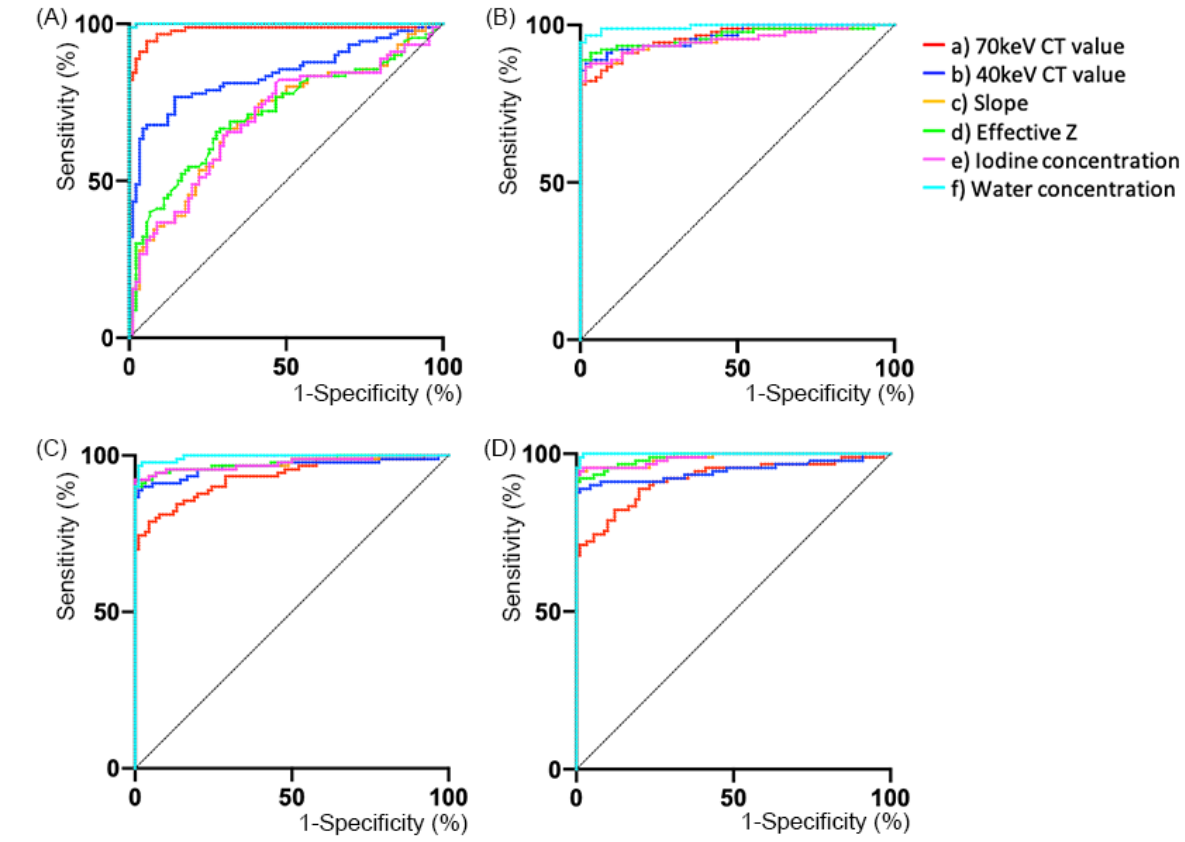
Figure 4. Receiver operating characteristic (ROC) analyses in non-contrast-enhanced ( A ) and contrast-enhanced CT including ( B ) hepatic arterial phase (HAP), ( C ) portal venous phase (PVP), and ( D ) delayed phase (DP) showing the comparisons between the difference in dual-energy CT (DECT) numbers derived from two regions of interest (ROIs) within the same organs (ROI 2–ROI 1 [liver], ROI 4–ROI 3 [spleen], and ROI 6–ROI 5 [kidney]), and the difference in DECT numbers derived from 2 ROIs placed on different organs (ROI 3–ROI 1 [spleen–liver], ROI 5–ROI 3 [kidney–spleen],